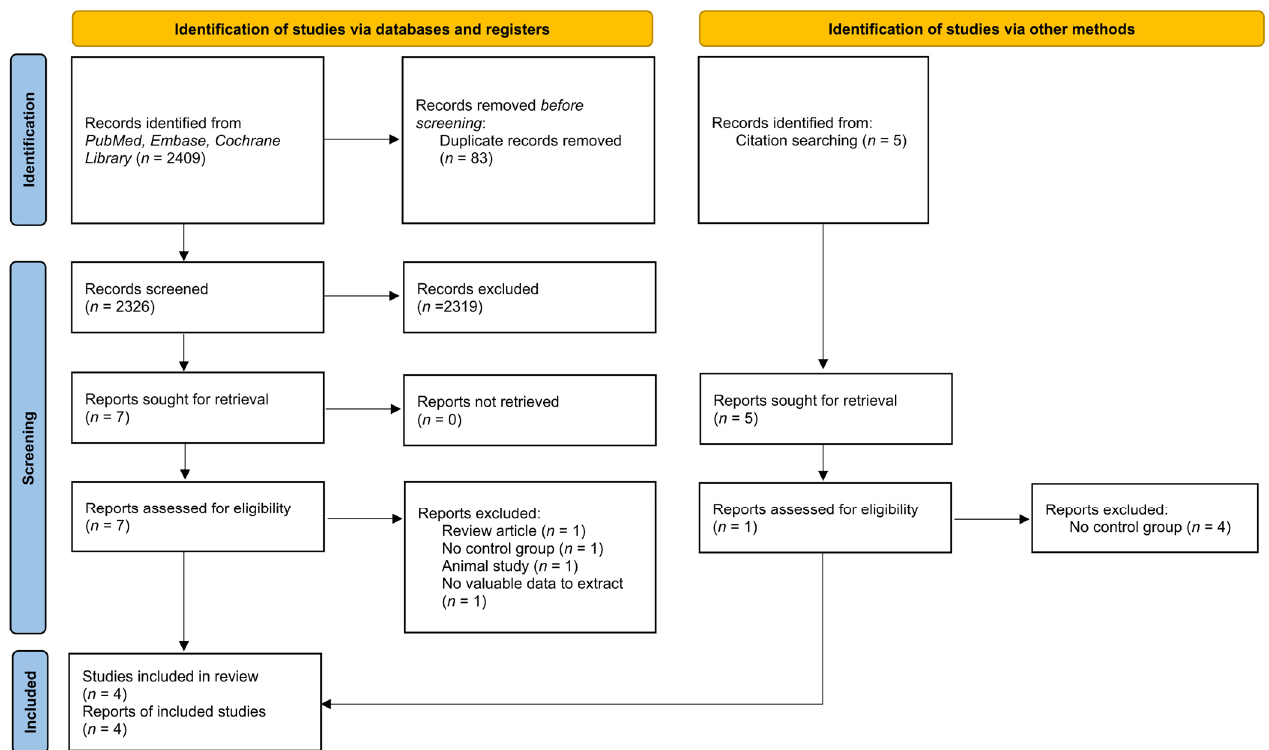
Figure 1. PRISMA (Preferred Reporting Items for Systematic Review and Meta-analysis) 2020 flow diagram for new systematic reviews which included searches of databases and other sources.